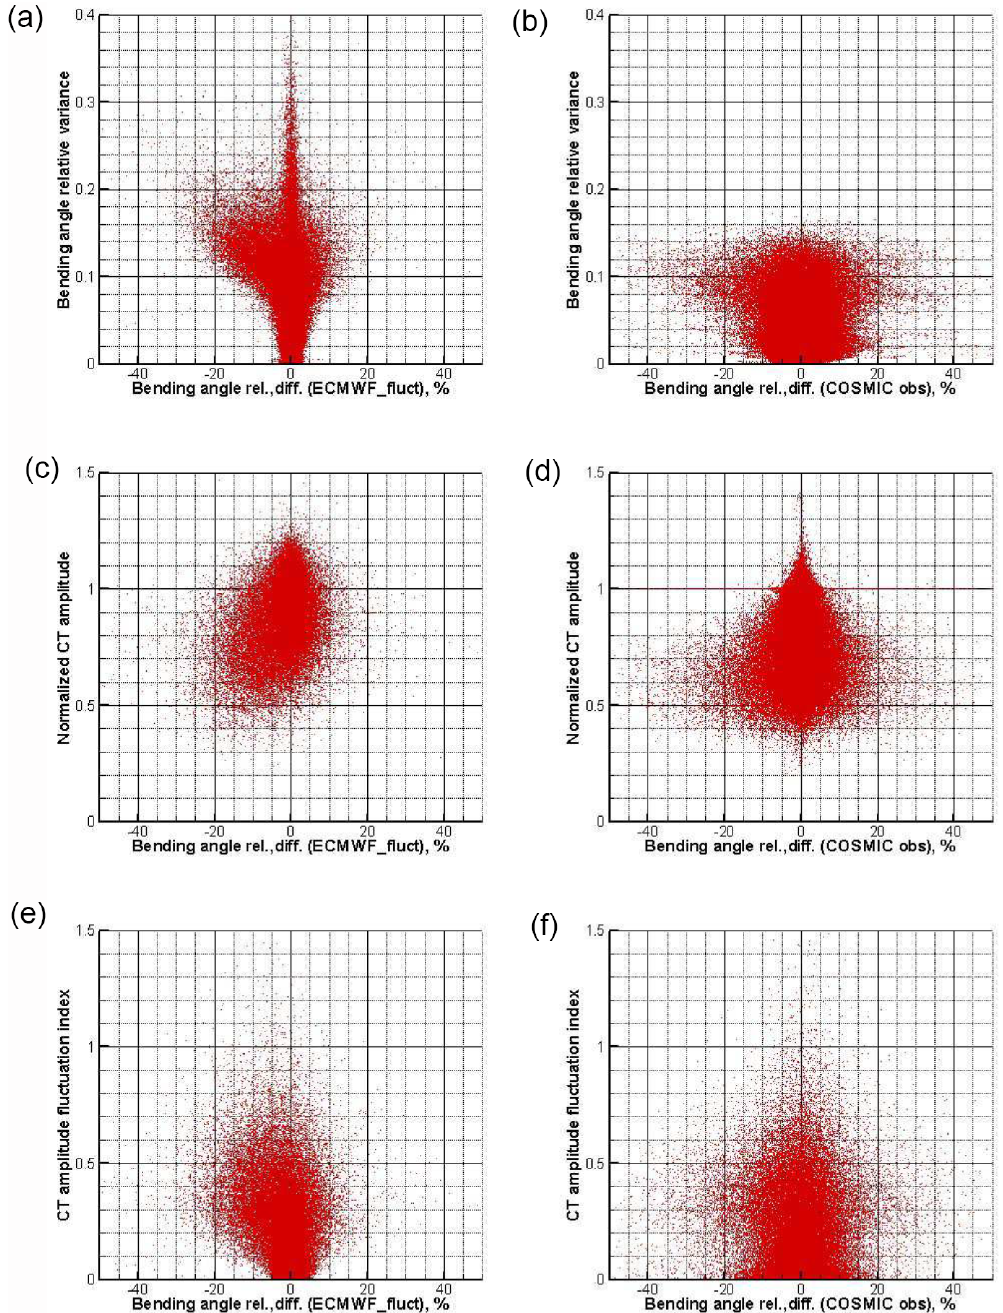
Figure 5. Scatter plot of the difference of fluctuation-effected and reference bending angle profiles ( x axis) for ECMWF simulations with refractivity fluctuations superposed (a, c, e) and COSMIC observations (b, d, f) versus the predictor variables ( y axis) bending angle relative variance (a, b) , normalized CT amplitude (c, d) , and CT amplitude fluctuation index (e, f) . The reference bending angles are from ECMWF simulations without refractivity fluctuations superposed. The same ECMWF fields and COSMIC data as for Fig. 4 were